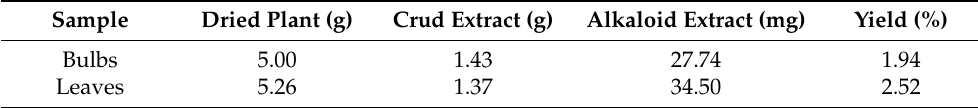
Table 2. Yield of alkaloid extract obtained from Crinum × amabile collected in Ecuador. Sample Dried Plant (g) Crud Extract (g) Bulbs